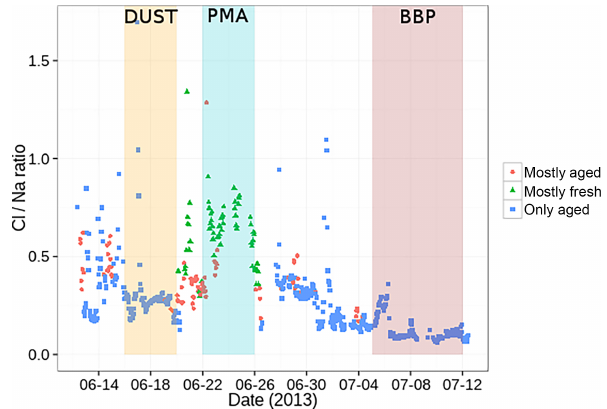
Figure 9. Comparison of the two instruments ATOFMS and PILS- IC for inorganic component of sea salt aerosols. The time series rep- resents the mass ratio of chloride to sodium ions calculated from the PILS-IC measurements. The marker colour represents the degree of ageing determined by the ATOFMS. Table 2. Characteristics of the three log-normal modes of aged sea salt aerosols measured by ATOFMS at Ersa station Mode Aerodynamical σ diameter